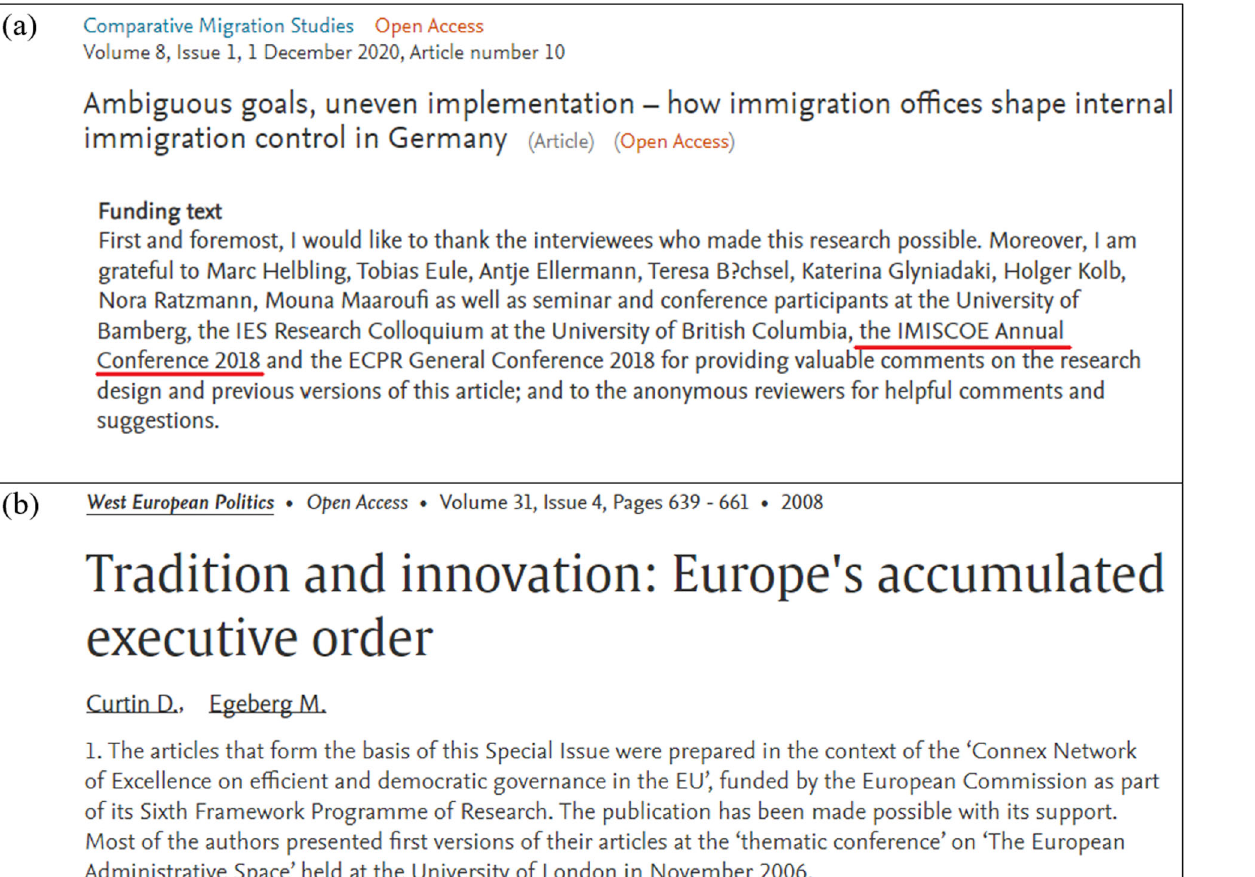
Fig. 7 Examples of bibliographic record in Scopus of articles with acknowledging feedback obtained from participants in a conference resulting from an old FP6 research project. a Bibliographic record in Scopus of an article published in 2020 acknowledging feedback obtained from participants in a conference resulting from a FP6 research project. b Bibliographic record in Scopus of an article acknowledging feedback obtained from participants in a conference resulting from a FP6 research